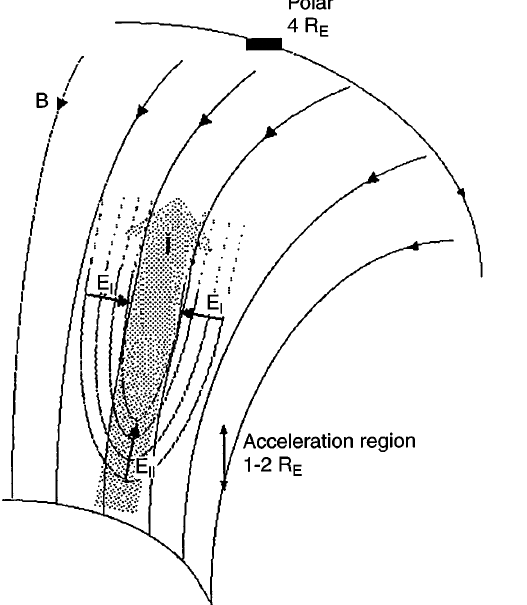
Fig. 1. The upward extended U-shaped potential model for auroral electric field. The acceleration region is usually thought to reside in the 1–2 R altitude range. Polar measures the electric field above the E acceleration region at about 4 R altitude. In the upward extended E U-shaped potential it is assumed that the flanks of ‘‘U’’ continue upward along field lines indefinitely. We do not find support for this model in our data